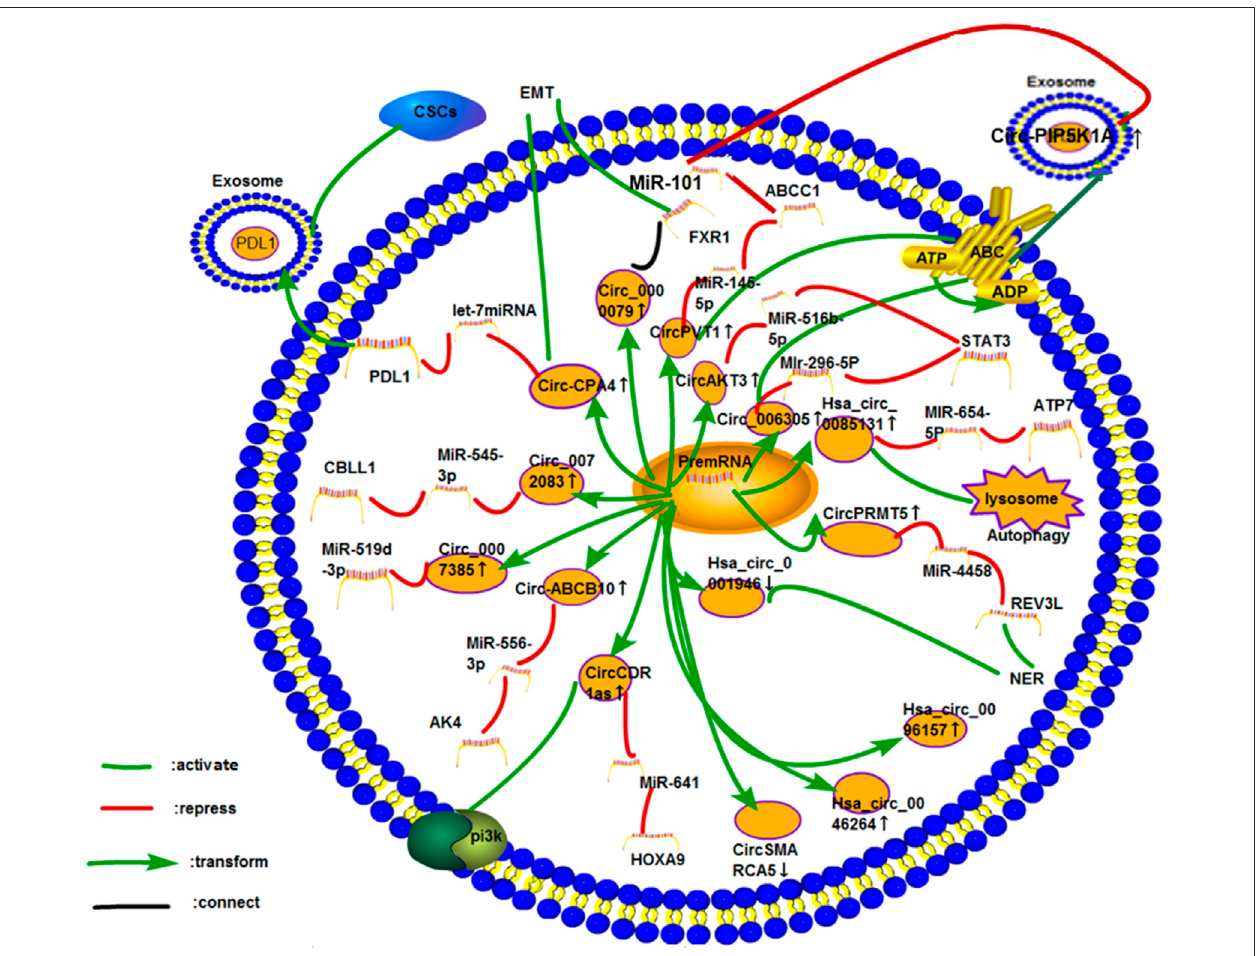
FIGURE 9 | Cisplatin resistance mechanism of circRNA in lung cancer. So far, 16 circRNAs have been studied in lung cancer. The mechanisms of cisplatin resistance in these articles include the most common ceRNA NET, exosomes, PI3K pathway, autophagy, ABC transporter, DDR (NER), and CSCs. Three circRNAs, namely,hsa_circ_0096157,hsa_circ_0046264, and CircAMARCA5,play roles incisplatin resistance in lung cancer. However, their speci fi cmechanisms have notbeen